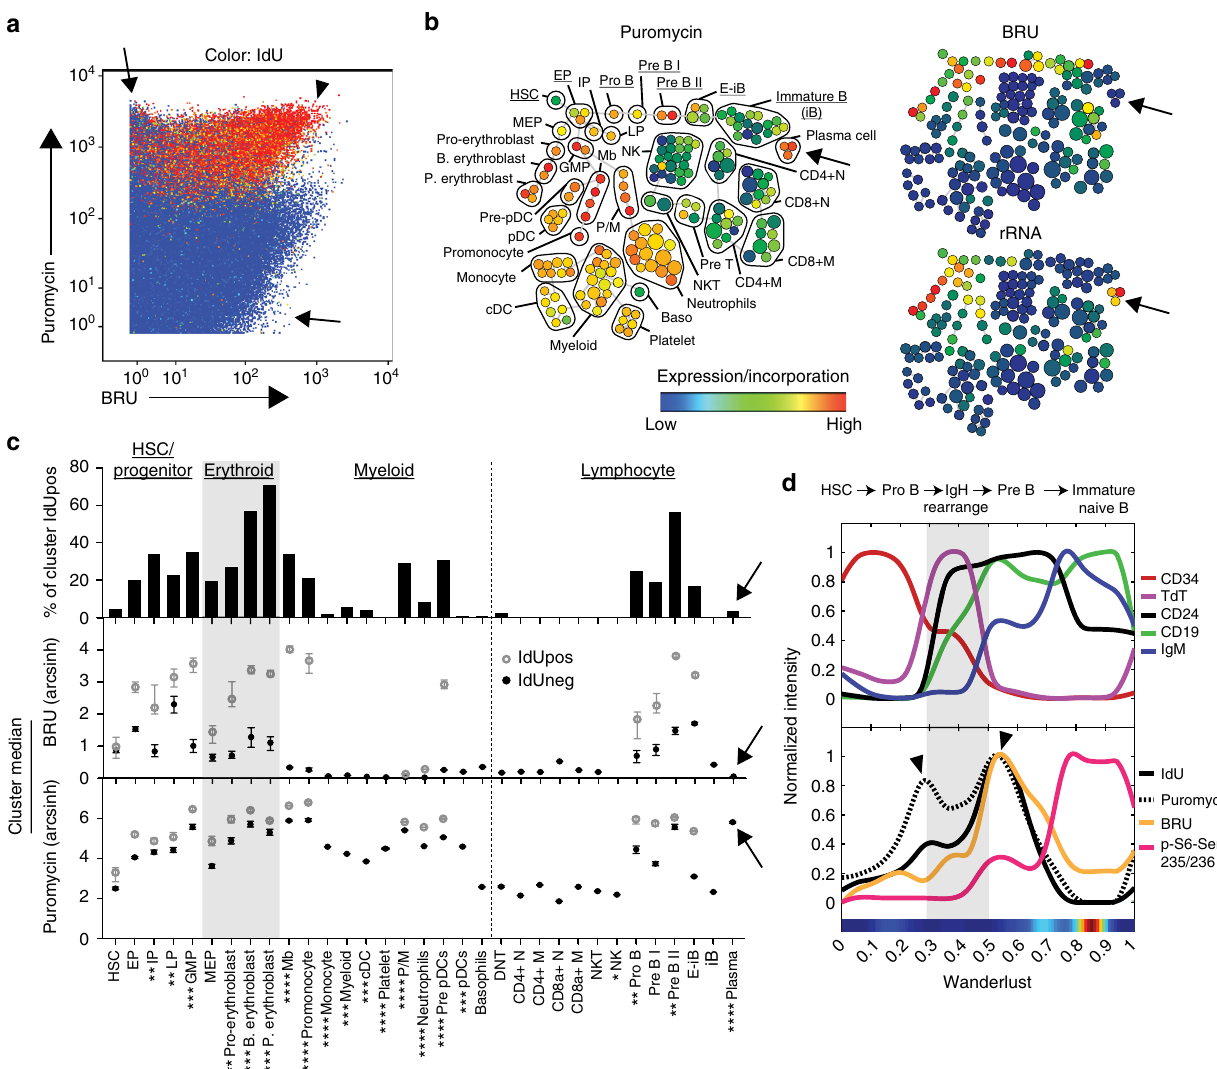
Fig. 5 Dynamic DNA, RNA, and protein synthesis across a human hematopoietic continuum can be linked to cellular function and developmental identity. a Plot of CD45pos immune cells from a healthy human bone marrow donor (color overlaid: IdU incorporation, color range: 0, 410 ion counts). Arrows highlight cells with high activity of RNA or protein synthesis, arrowhead indicates high biosynthesis activity of all three biomolecules. b Manually annotated SPADE map of single cell data in a , clustered according to immune-cell phenotype and color-overlaid by the median incorporated puromycin (left), BRU (top right) and ribosomal RNA expression (bottom right) for each cluster. c Quanti fi cation of DNA synthesis (percent IdU positive), RNA and protein synthesis for each phenotype group in b . Values are displayed for both IdU positive and IdU negative sub-populations only when greater than 4% of the parent population is positive for IdU. Error bars, 95 percent bootstrap con fi dence interval, see Supplementary Table 6 for total cell observations in each phenotypic group. Arrows highlight plasma cells. d Wanderlust trajectory analysis of B-cell lineage (underlined in b ) ordered according to developmental pseudo-time with functional markers (top), and activity of DNA, RNA, protein synthesis, and p-S6 expression in the same B-cell developmental axis (bottom). Arrowheads highlight developmental stages immediately before, and after, B-cell somatic recombination. Experiment was performed on two independent donor bone marrow samples, with data from the additional donor presented in Supplementary Fig. 6. p -values symbols expressed as follows: 1.0 × 10 − 7 > p > 1.0 × 10 − 14 *; 1.0 × 10 − 14 > p > 1.0 × 10 − 21 **; 1.0 × 10 − 21 > p > 1.0 × 10 − 28 ***; p < 1.0 × 10 − 28 ****. Signi fi cance was obtained by the Friedman- Rafsky test, evaluating BRU and puromycin incorporation in a given phenotypic population relative to